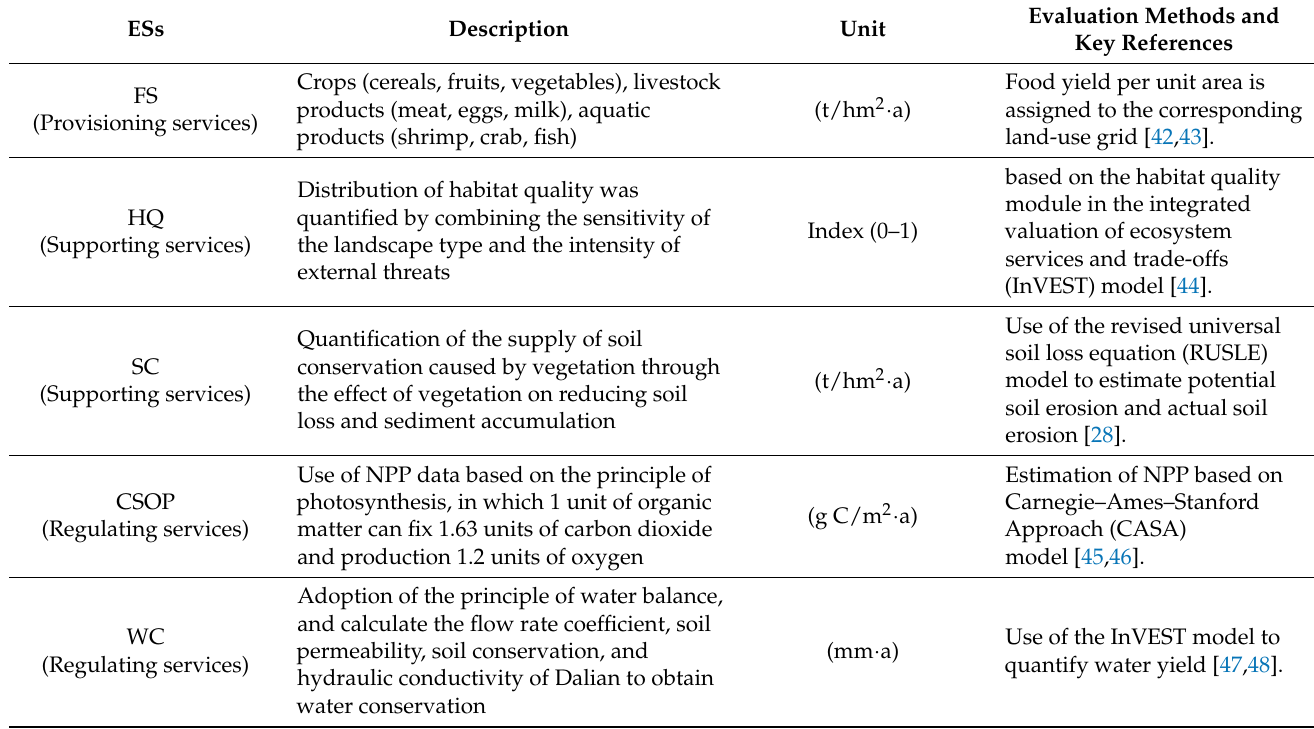
Table 2. Indicators and methods used to measure each